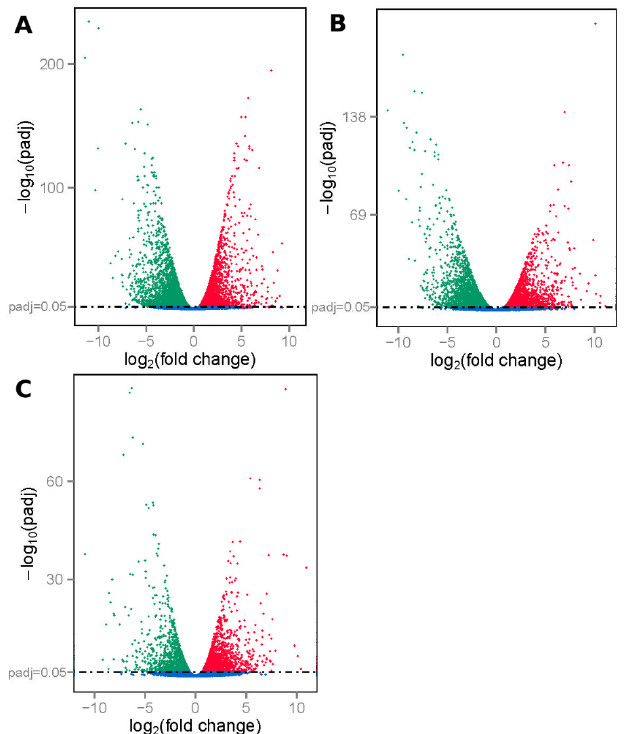
Figure 2. Apex levels of gene expression in ( A ) natal pigs vs. 65-day embryonic (E65) pigs, ( B ) adult pigs vs. E65 pigs and ( C ) adult pigs vs. natal pigs. The padj of 0.05 is represented by a horizontal line. The DEGs downregulated and upregulated were represented by red points and green points, respectively. The DEGs in the muscle of natal vs. E65, adult vs. E65 and adult vs. natal were